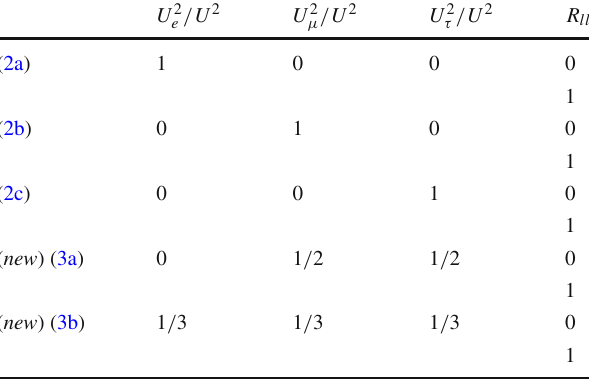
Table 1 The complete list of the benchmark points recommended in this document. For each of the five flavour ratios, when possible,